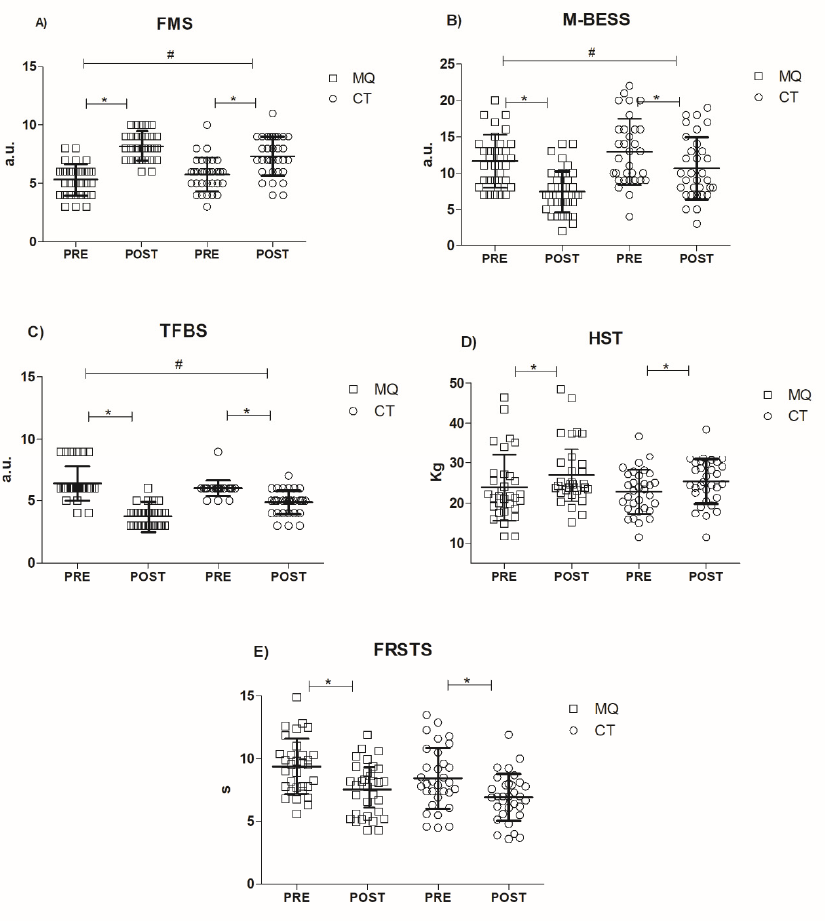
Figure 1. Functional parameters (“( A )” FMS Composite Score, “( B )” M-BESS, “( C )” TFBS, “( D )” HST, “( E )” FRSTS). * Significant main effect of time before and after testing ( p < 0.05). # Significant interaction ( p < 0.0001).